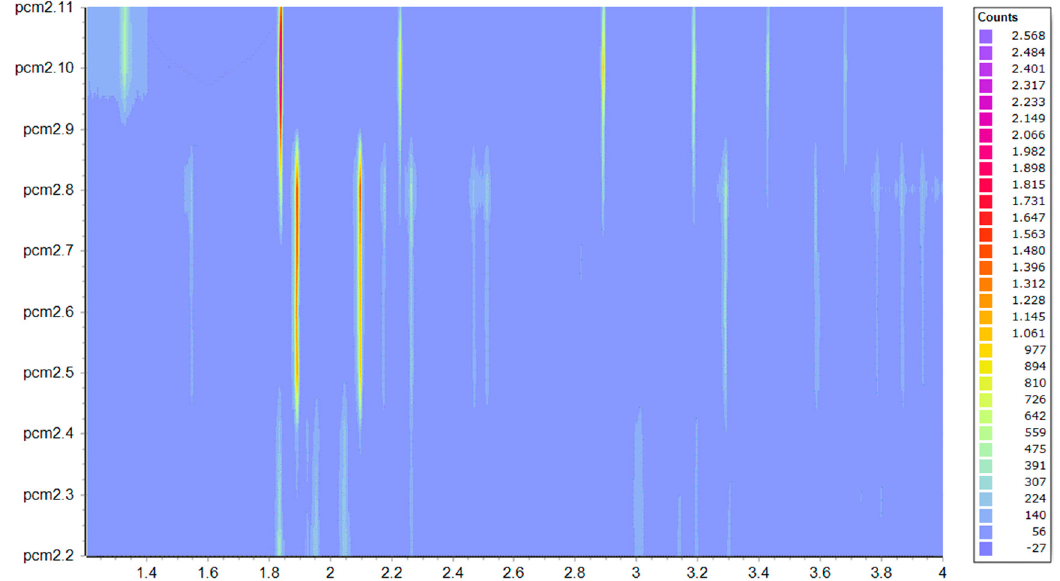
Figure 12. Surface plot of XRPD profiles of HI in the presence of p -coumaric acid, corresponding to the P 2 1( η ) (pH: 5.44 to 5.82), P 2 1( ζ ) (pH: 6.00 to 6.89) and R 3 (pH: 7.21 to 7.95) polymorphs. The vertical axis corresponds to particular sample codes, the horizontal axis to a specific 2 θ range, while, different colors represent intensities denoting the exact position of diffraction peaks. Data were collected on ID22-ESRF (RT, λ = 1.30017 (2) Å).